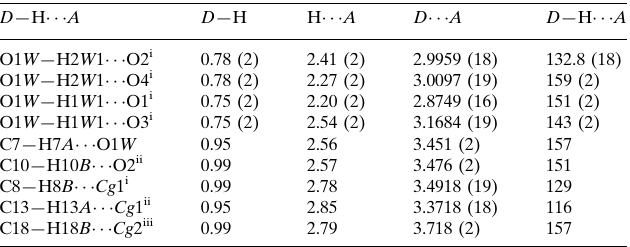
Hydrogen-bond geometry (A˚ , (cid:2)